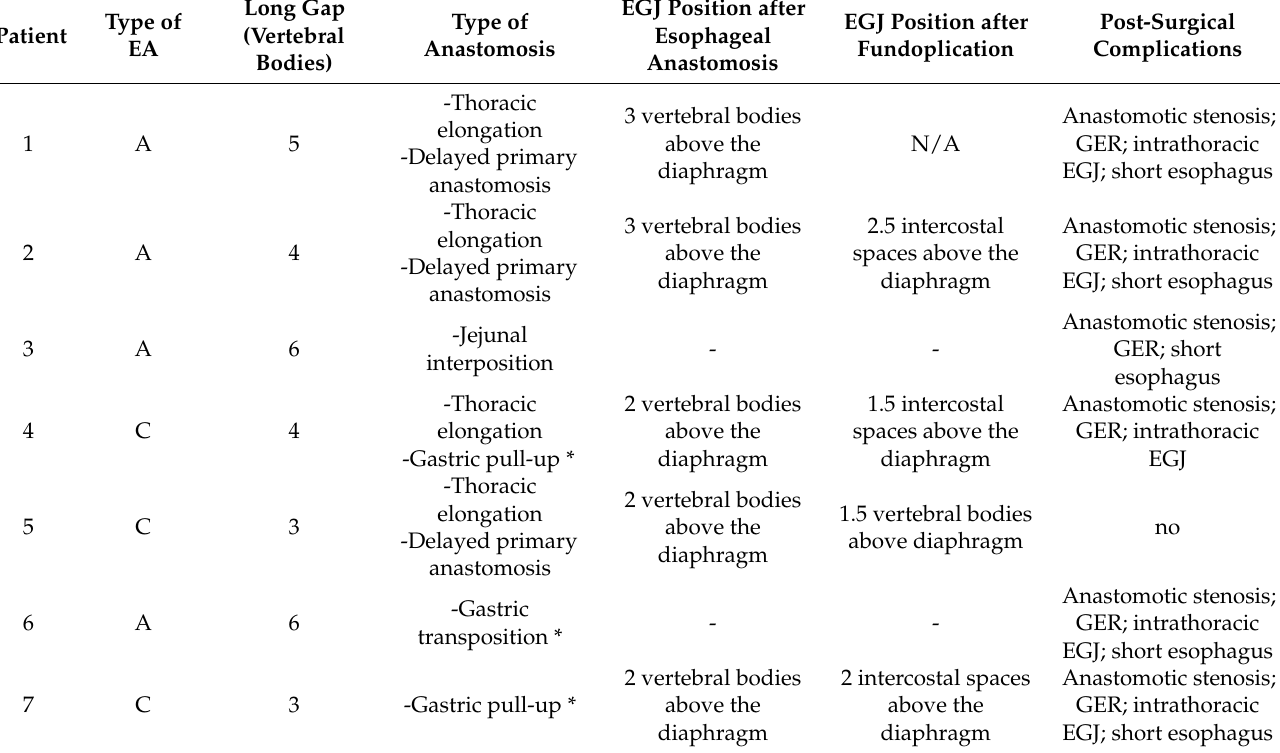
Table 2. Type of esophageal surgery, post-surgical complications and location of esophago-gastric junction (EGJ).